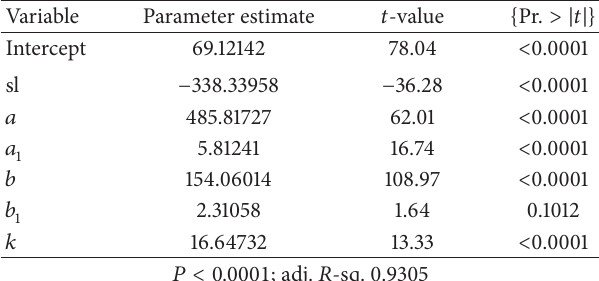
Table 5: Statistics of multiple linear regression for NPV.